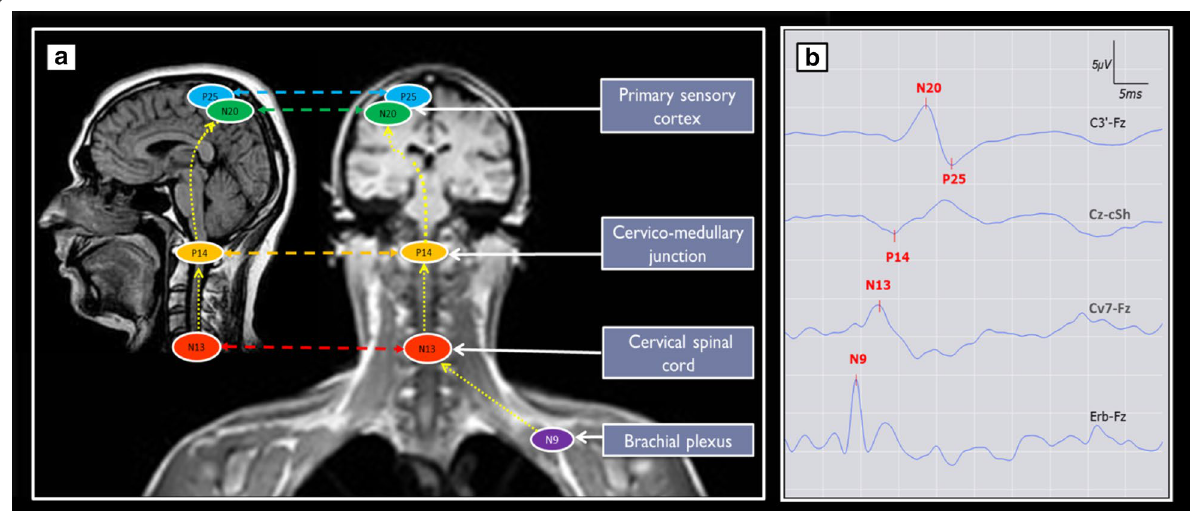
Fig. 2 Schematic representation of median nerve’s somatosensory evoked potentials (SSEP) responses localizations on brain MRI ( a ) and typical examples of their normal wave forms as well as recording electrodes montages ( b ). SSEP elicited by electric stimulation (15 mA) of median nerve at the wrist: N9 , N13 and P14 , respectively, the brachial plexus, cervical spinal cord, and cervico‑medullary (subcortical) responses. N20 and P25 are responses of the primary sensory cortex. N9 – N13 inter‑peak latencies (IPL) represent a proximal peripheral nerve conduction time, and P14 – N20 IPL the intracranial conduction time (ICCT). Recording and reference electrodes were placed at Cv7 (7th cervical vertebra)—Fz: for the N13 cervical spinal cord response and Cz‑cSh (contralateral shoulder): for the subcortical far‑field potential: P14 . The cortical components, N20 and P25 were recorded at the contralateral C3 ′ or C4 ′ positions (2 cm behind C3 or C4) according to the international 10–20 system. Two sets of 500 sweeps were